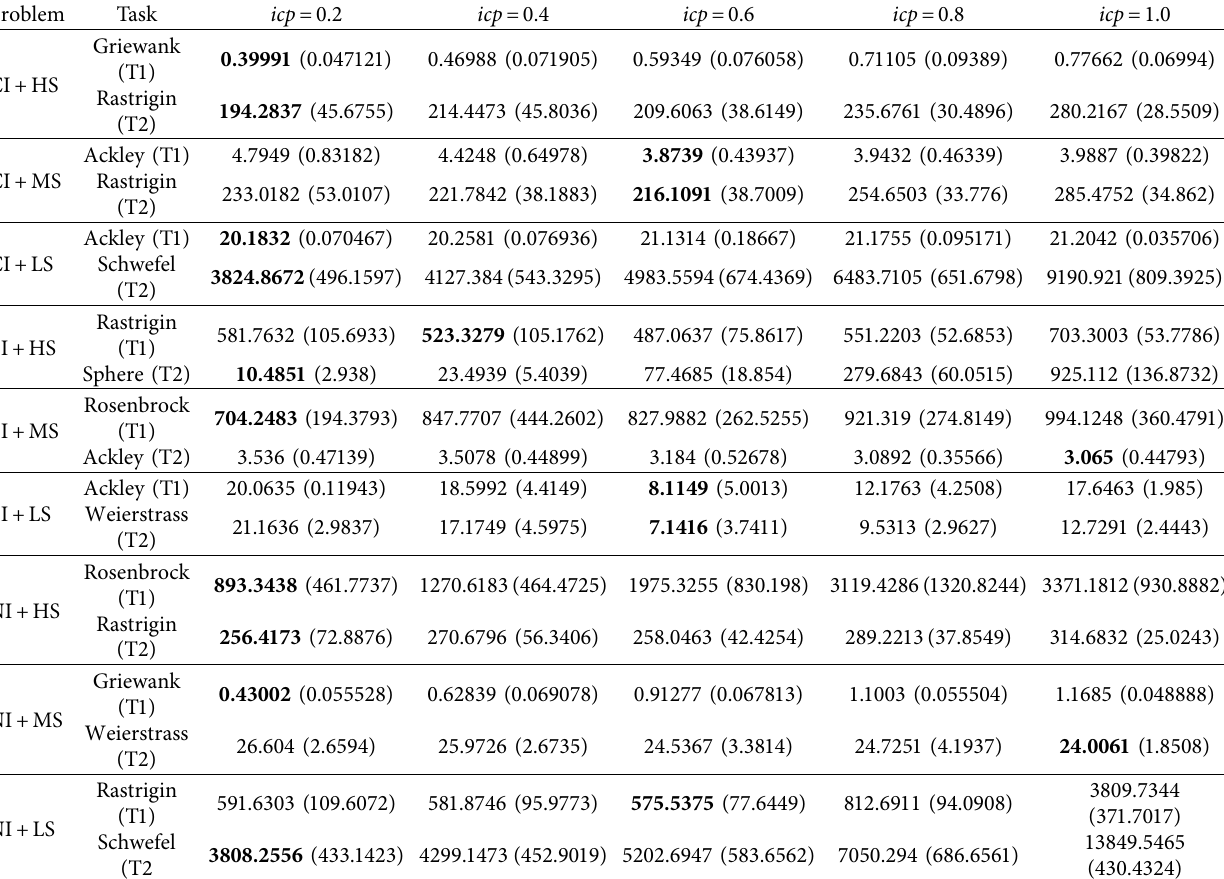
Table 1: Results obtained by MFEA under different interpopulation crossover probabilities.